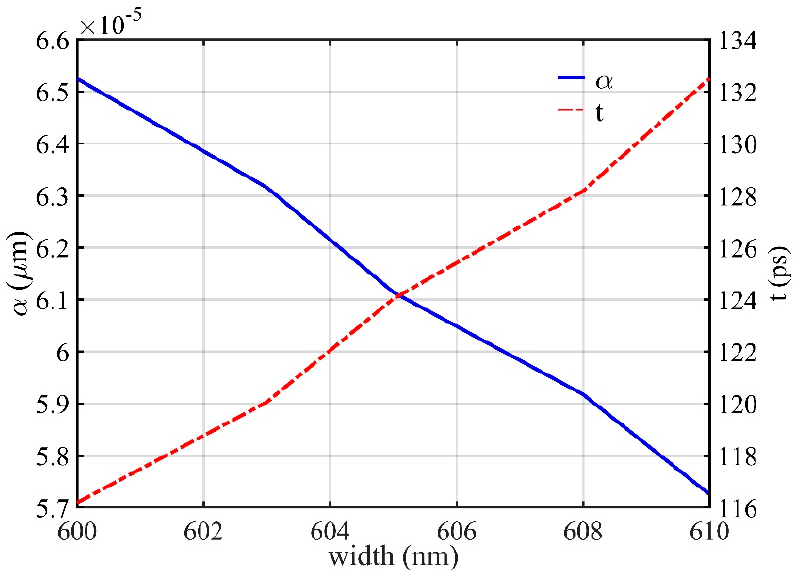
Figure 13. Curves of waveguide width, loss coefficient and effective buffering time.